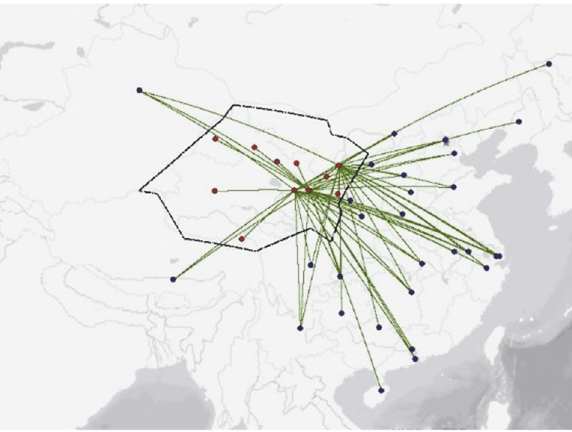
Figure 1: The route network of the Lanzhou control area.